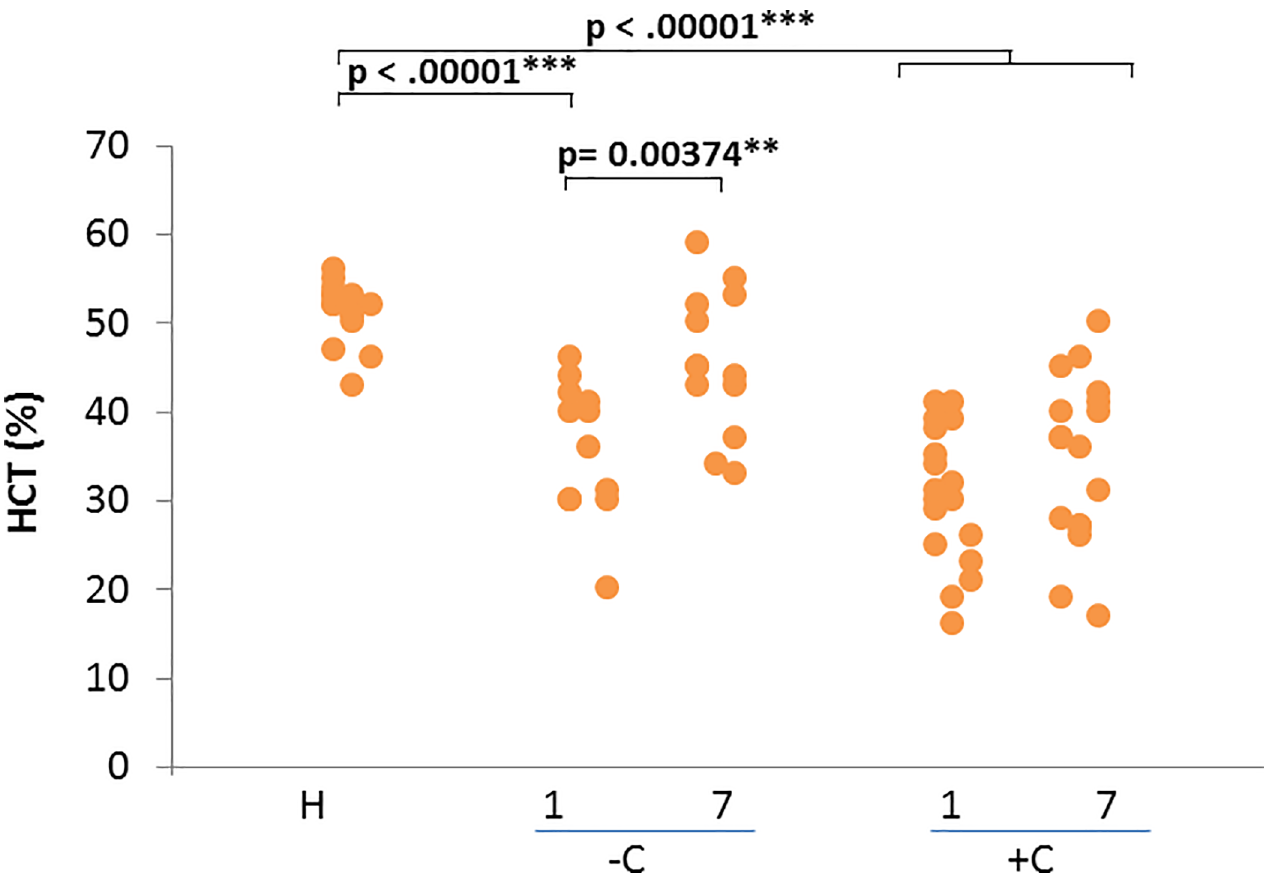
Fig 5. Hematocrit (HCT) values and outcome. From left to right hematocrit values for healthydogs and values registeredon day 1 and 7 of treatment for uncomplicated (-C) and complicated cases (+C). Mann-whitney test p- values are shown for comparisonof different groups.